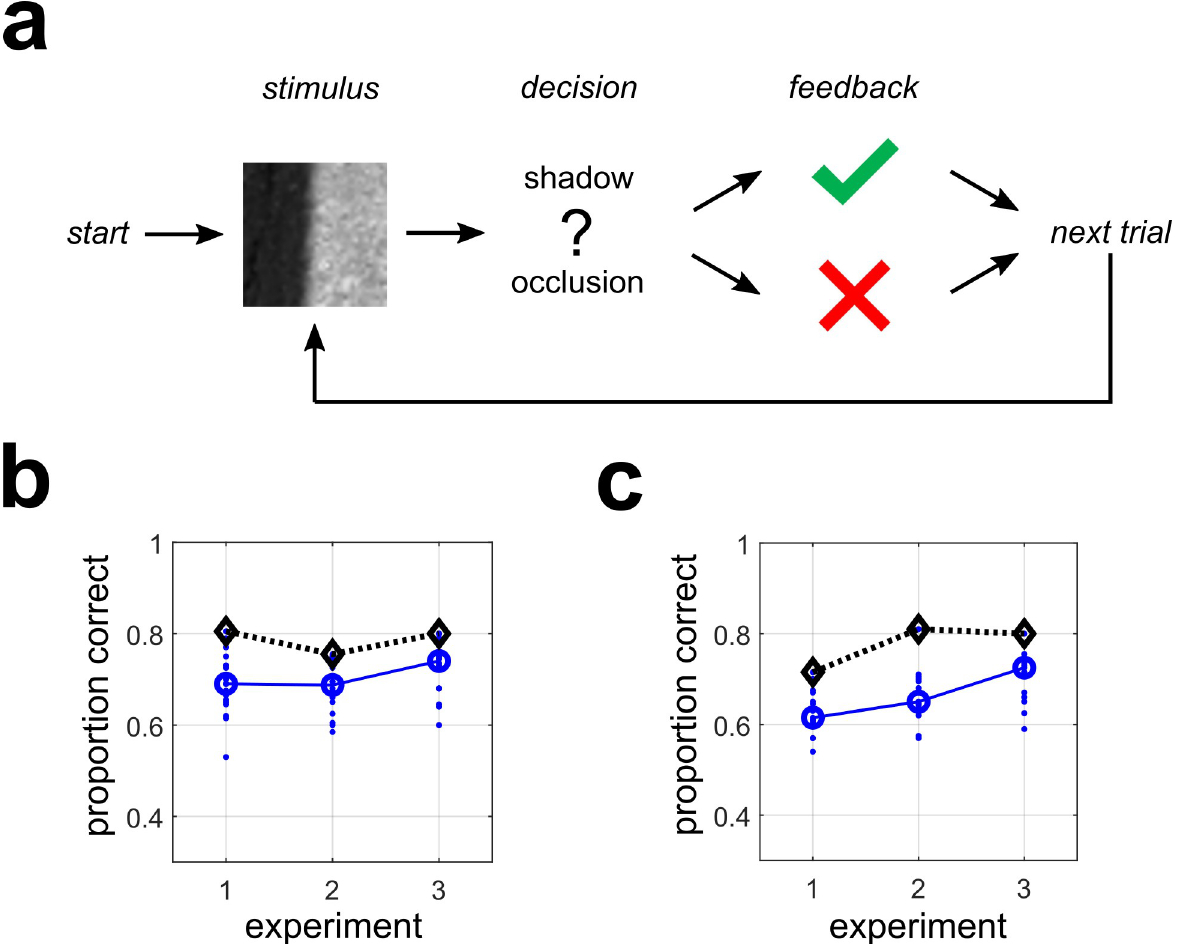
Fig 10. Performance of human observers for each experiment for two different stimulus display methods. ( a ) Schematic outline of a single trial for the psychophysical experiments. For each experiment, human observers classified image patches as either shadows (shown here) or occlusions. ( b ) Performance of all observers (N = 18) on each Qualtrics ( QT) survey, as measured by proportion correct. Blue dots indicate individual observers. Blue circles indicate the median, and black diamonds indicate maximum performance. ( c ) Same as (b) but for lab ( LB ) experiments (N =